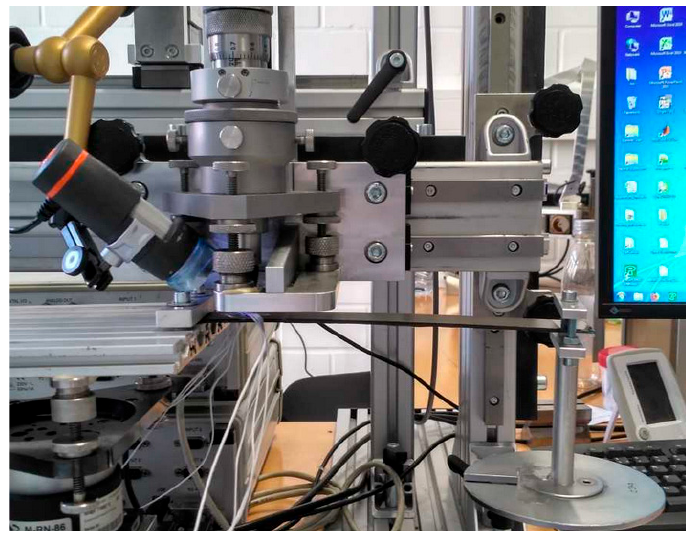
Figure 13. Experimental setup used for validation of the residual stress profiles.